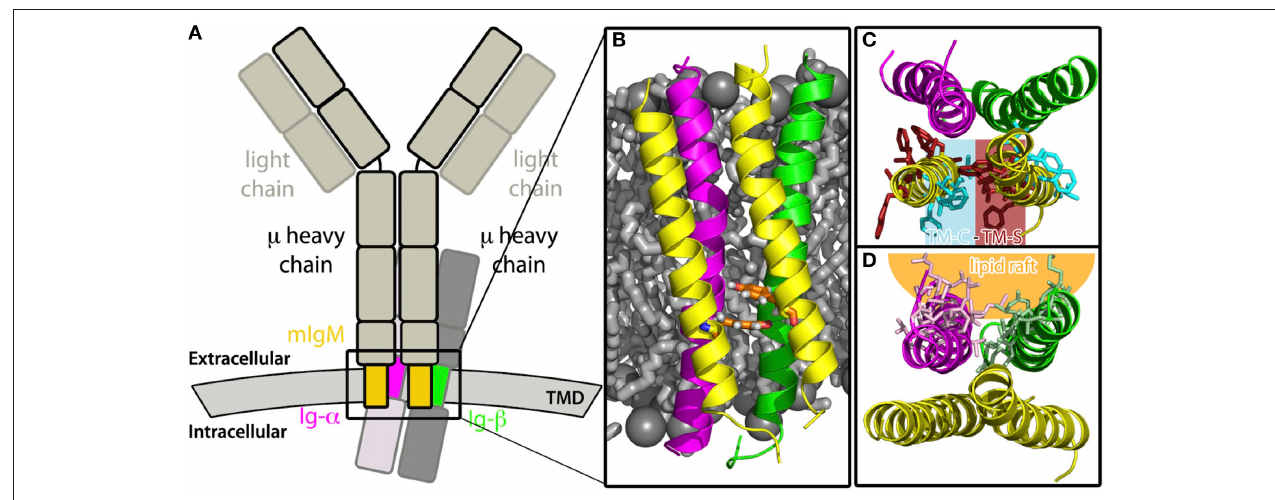
FIGURE 10 | Summary. (A) Sketch of a monomeric IgM-BCR. The transmembrane domains, whose assembly was studied here, are highlighted in color, namely the TMDs of the µ chains are colored yellow, Ig- α magenta, and Ig- β green. (B) Front view of the modeled IgM-BCR transmembrane domain embedded in a POPE membrane (shown as gray sticks and spheres). The protein helices are shown in cartoon representation and the coloring corresponds to subfigure A. Tyr463 of both µ heavy chains which interact with Ig- α /Ig- β , thus strongly stabilizing the IgM-BCR TMD, are highlighted by orange sticks. Other side chains were omitted for clarity. (C) View on the IgM-BCR TMD in cartoon representation from the extracellular side. The helical transmembrane tetramer is stabilized by interactions of one TM-C with one TM-S site of the individual µ chains. Residues which were shown to play a key role in mIgM stabilization (see Figures 3C,D ) are shown as sticks and colored in cyan (conserved site, TM-C), or in darkred (specific residues, TM-S site). Other side chains and hydrogen atoms are omitted for clarity. (D) Extracellular view on the IgM-BCR TMD in cartoon representation with highlighted residues (stick representation) of Ig- α /Ig- β , which preferably interact with lipid-raft like domains.